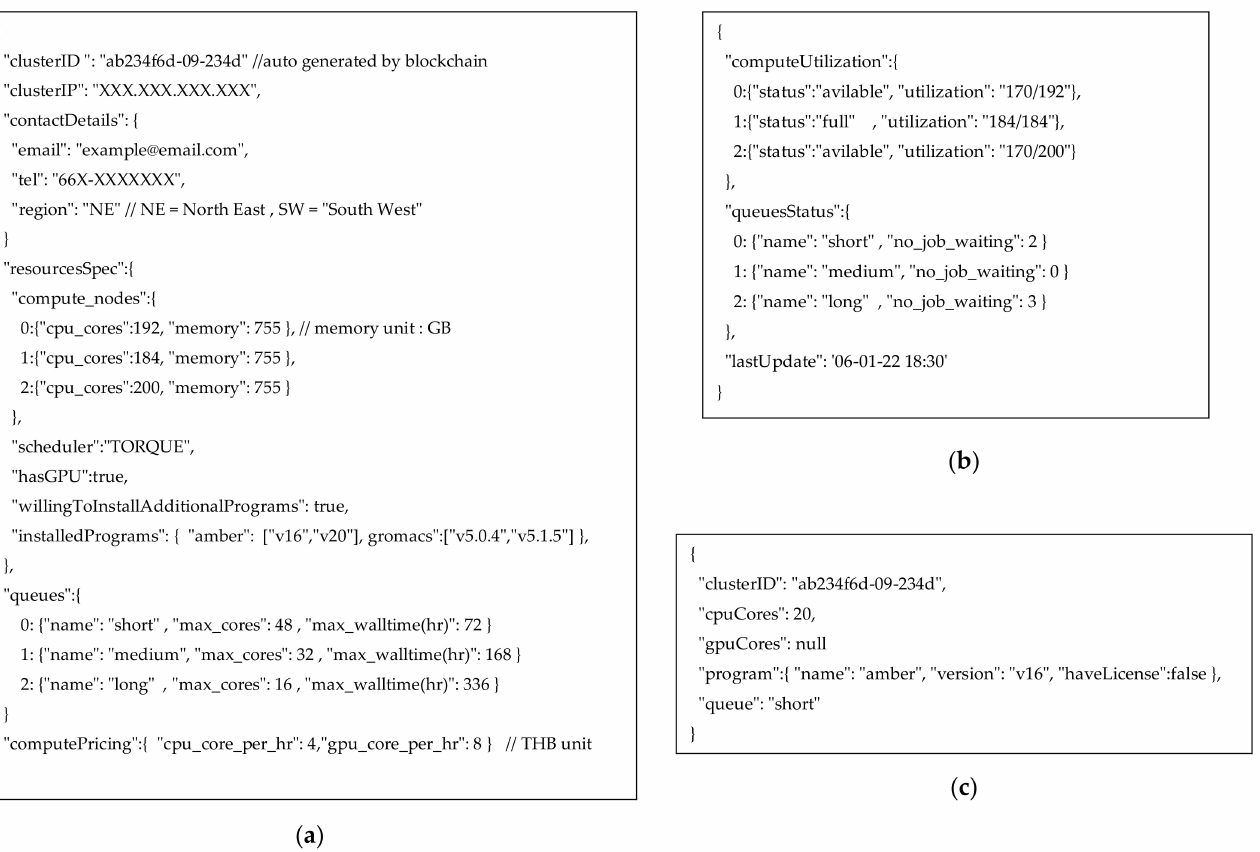
Figure 5. Data Object in JSON format. ( a ) HPC System Object (stored on blockchain state); ( b ) Cluster